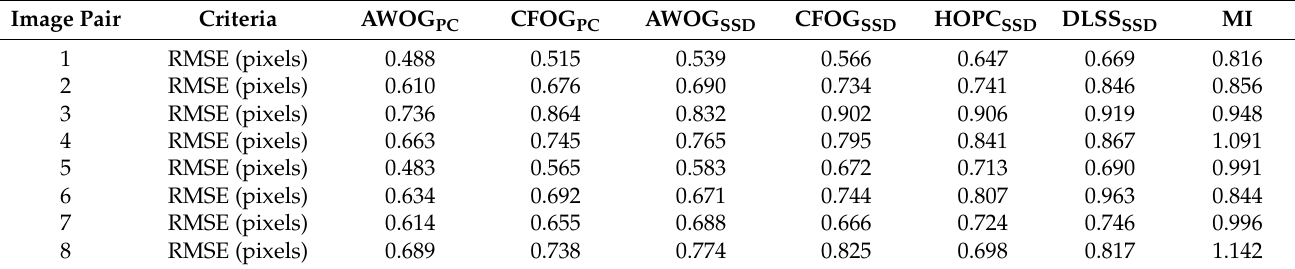
Table 2. The detailed RMSE values of all methods with a template window of 91 × 91 pixels. Image Pair